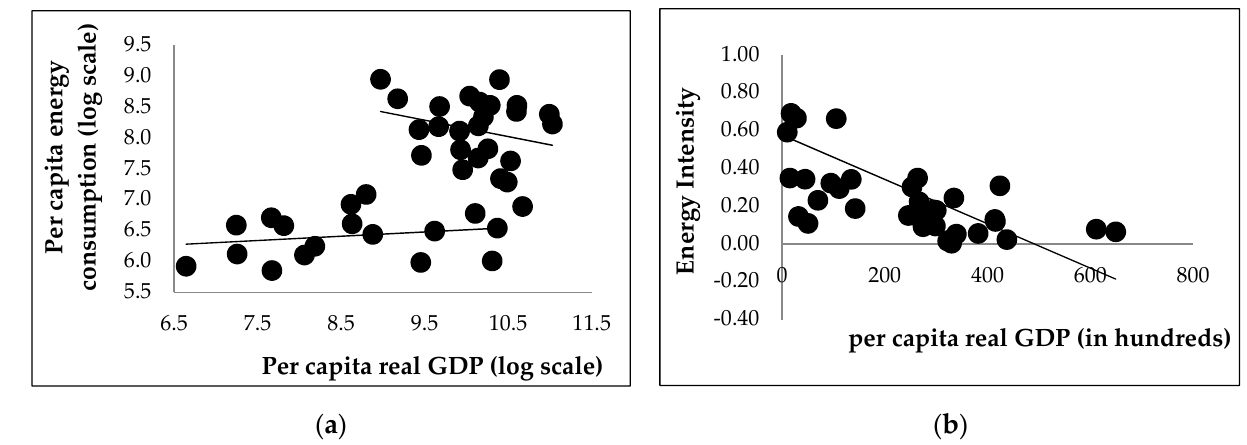
Figure 3. ( a ) Real GDP per capita and energy consumption per capita; ( b ) income and energy intensity (period averages for 1970–2016).